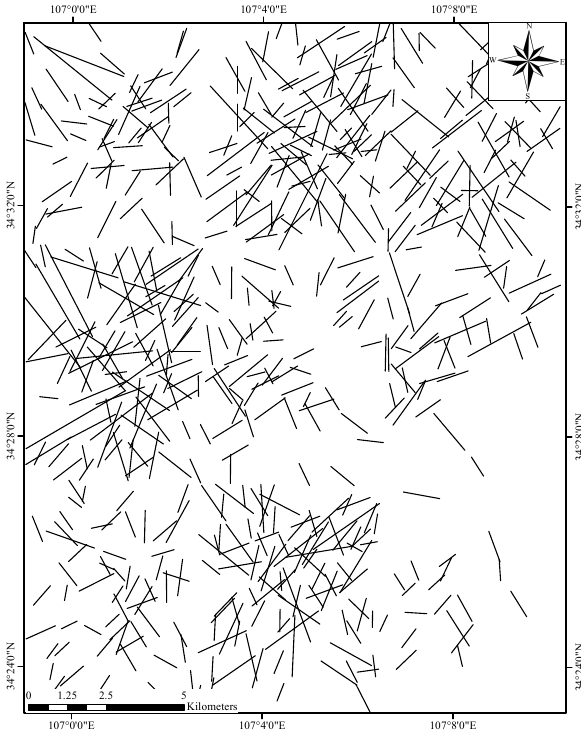
Figure 5. The final